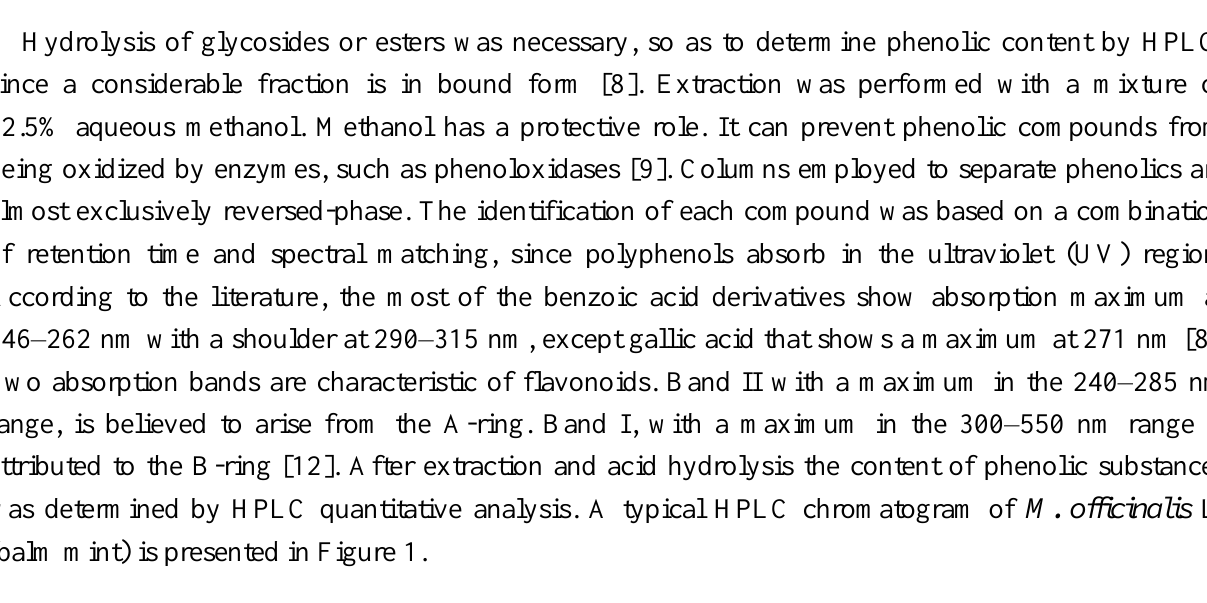
Figure 1. Typical HPLC chromatograph of M. officinalis L. where: 1, gentistic acid; 2, p -hydroxybenzoic acid; 3, (+)-catechin; 4, caffeic acid; 5, ferulic acid; 6,